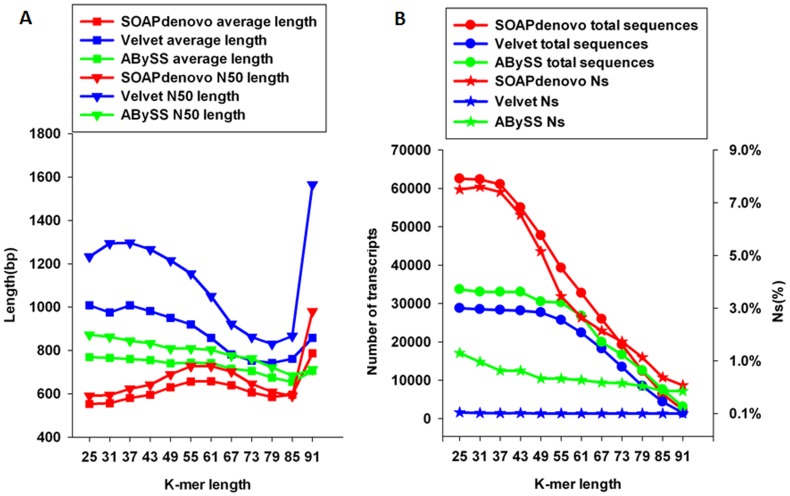
Performance of three programs using the SK method.The statistics of HQ read assembly by SOAPdenovo (red), Velvet (blue) and ABySS (green) with different single k-mer lengths (x axis). Assembly statistics metrics included the average contig length (squares), the N50 length (triangles), total sequences (circles) and percentage of Ns (stars).